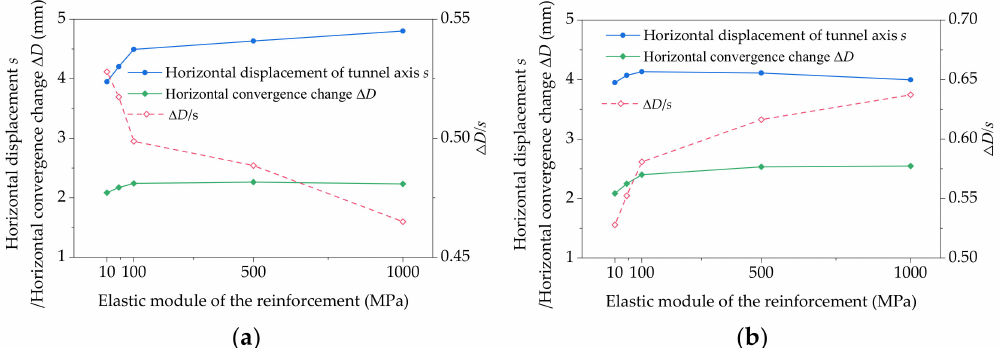
Figure 10. Tunnel displacement and convergence under different grouting sequences. ( a ) From far to near (Case 1); ( b ) from near to far (Case